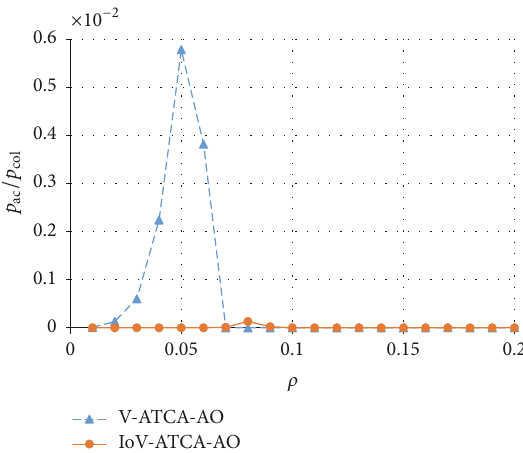
Figure 4: Type I accident rate in two kinds of model.